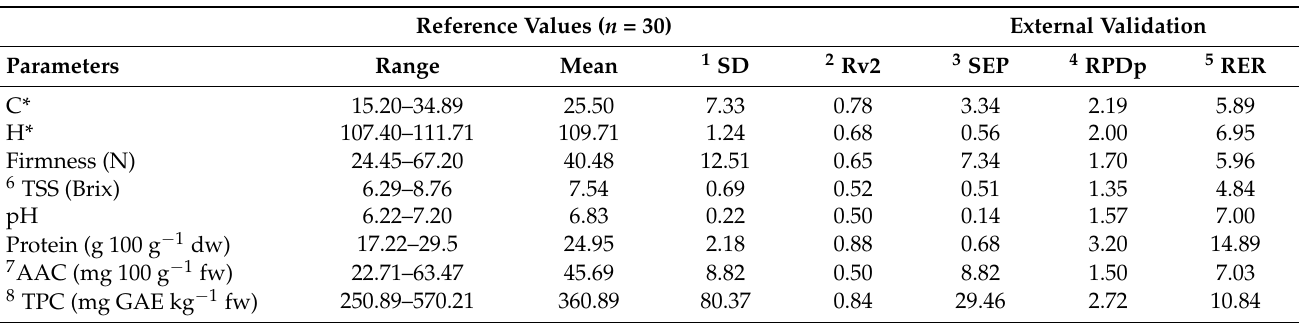
Table 4. Reference values and external validation statistics of the NIRS calibrations for quality compounds in